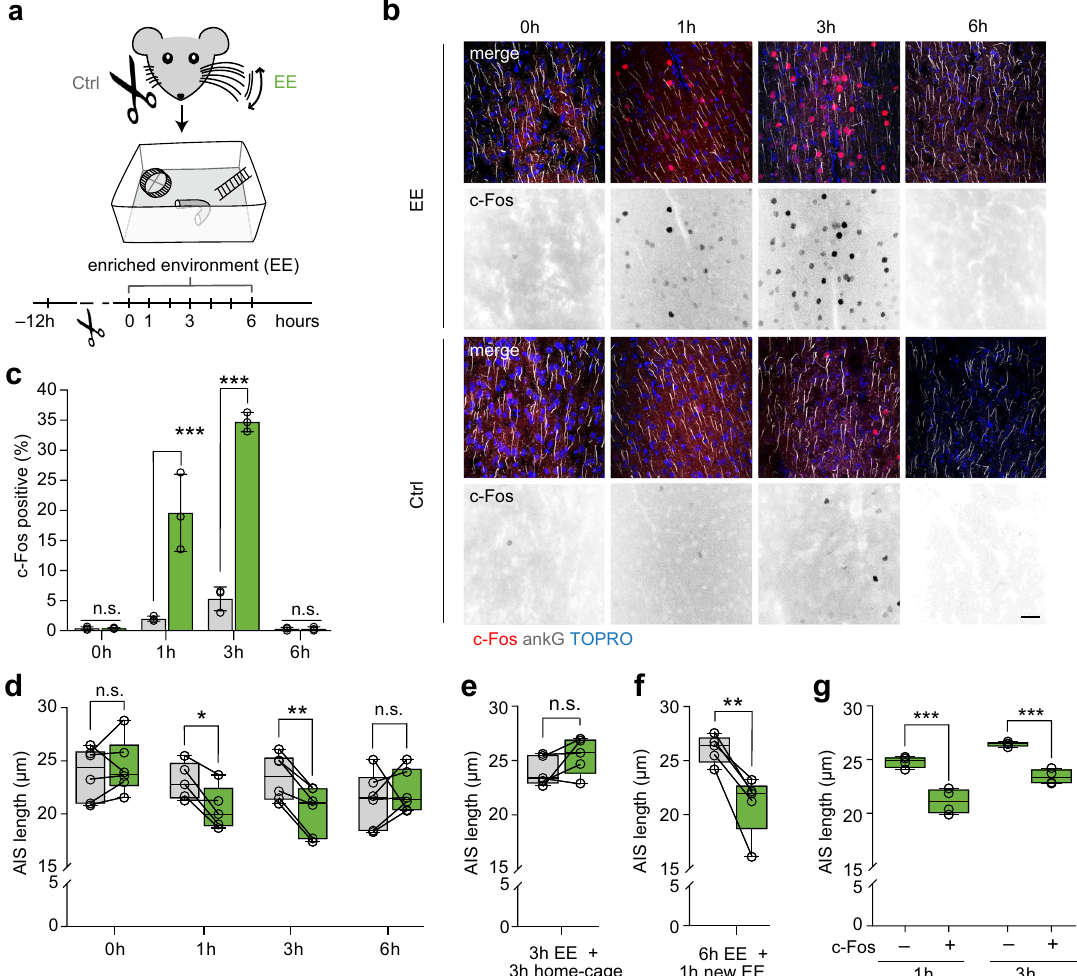
Fig. 4 Rapid structural AIS remodeling after exposure to an enriched environment (EE). a Experimental design: P28 mice ( n = 5 – 6 biologically independent experiments/time point), exposed to EE conditions 12 h after unilateral whisker trimming. Mice remained in EE for 0, 1, 3, and 6 h, respectively, and were sacri fi ced immediately after. Layer II/III S1BF pyramidal neurons contralateral to the remaining whiskers represented stimulated side